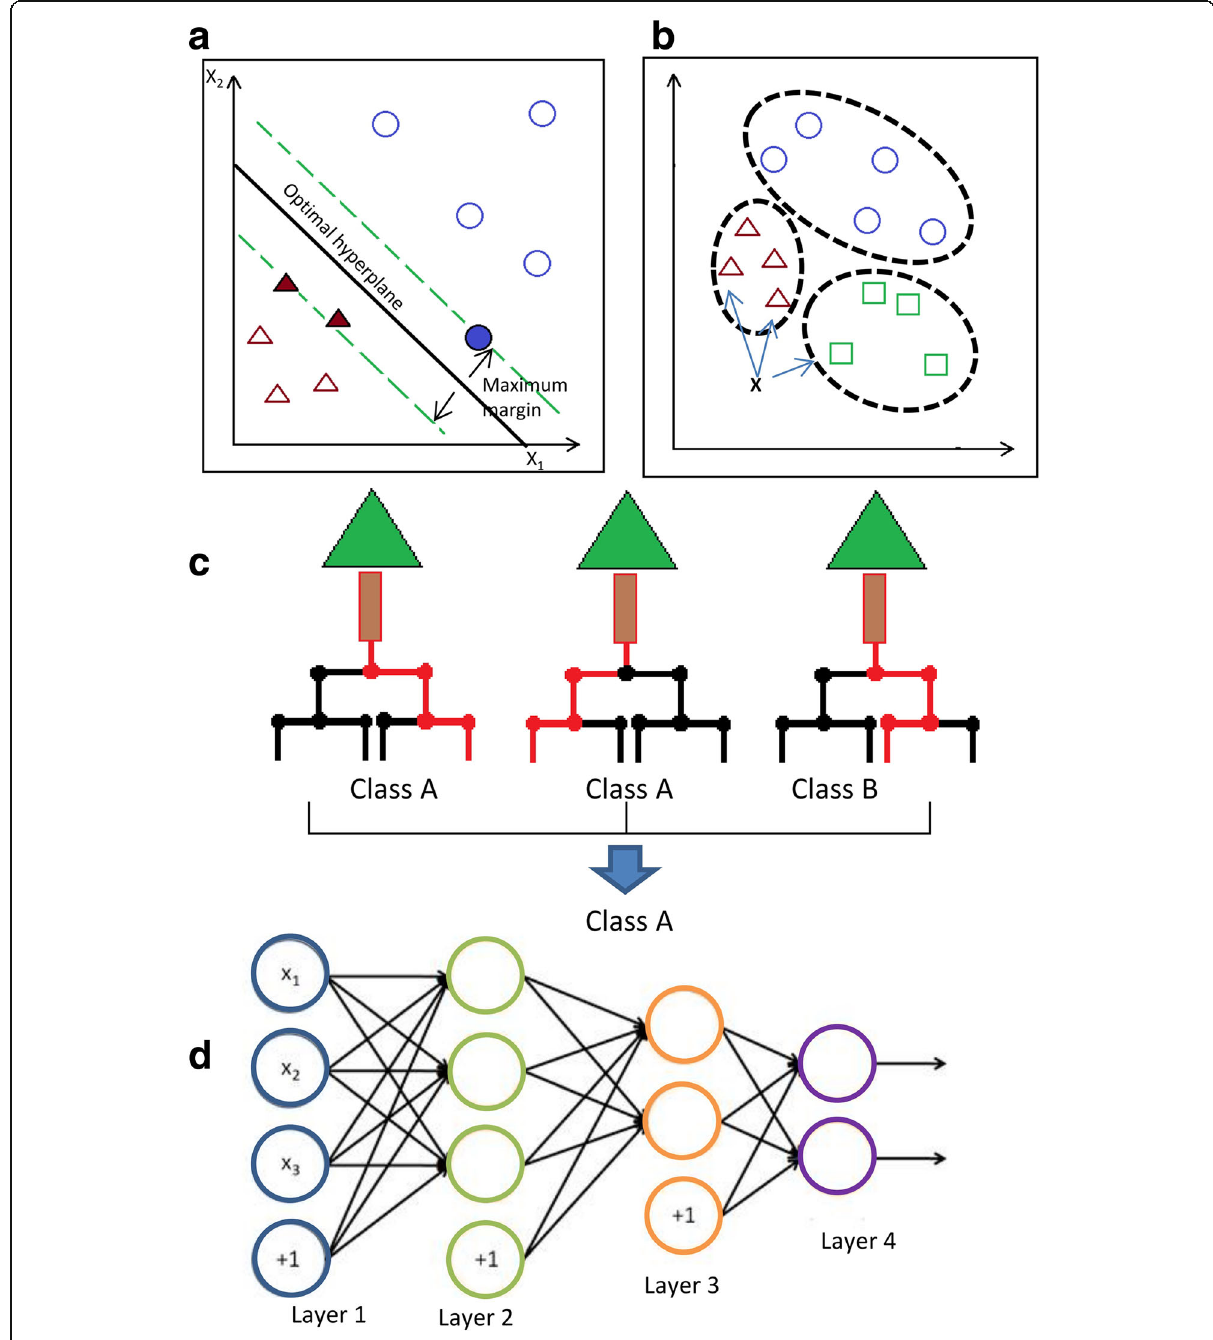
Fig. 1 Common ML algorithms. a Support vector machine (SVM), a widely used supervised learning method, generates a hyperplane in higher- dimensional feature space to maximize the largest minimum distance between the separate labeled support vectors. b K-nearest neighbor classification (KNN), a instance-based learning (lazy learning), classifies objects on the based of closet training data in feature space by assigning a label based on the most dominant class of its k nearest neighbors (here, k = 3). c The random forest algorithm, an ensemble classifier, generates classifiers that are known as decision trees, which utilizes input traits as branch nodes to resemble a tree structure, to differentiate the training data into “ leaves ” referring to the class that terminates a series of nodes and branches. It yields reliable predictions for new input by voting from an ensemble of decision trees. d Artificial neural networks (ANN), the input (far left) is linked to “ artificial neuron ” by means of weighted connections, after a process of the summation, the bias, and the activation function, the input propagates to the output node (far right) for